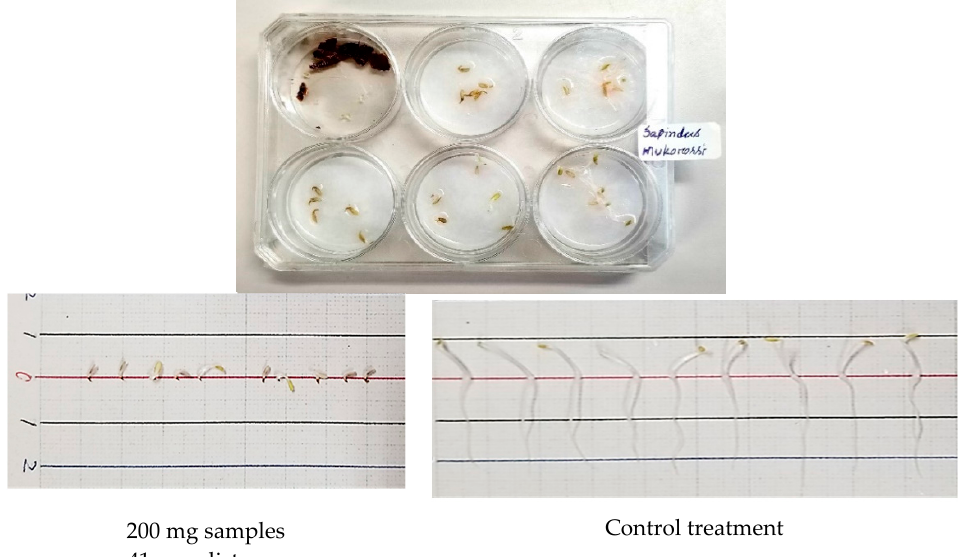
Figure 5. Growth level evaluated by DP method, considering 200 mg by dry pericarp of S. mukorossi and 41 mm distance growth status, compared with the control treatment on L. sativa seedlings’ radicle and hypocotyl.